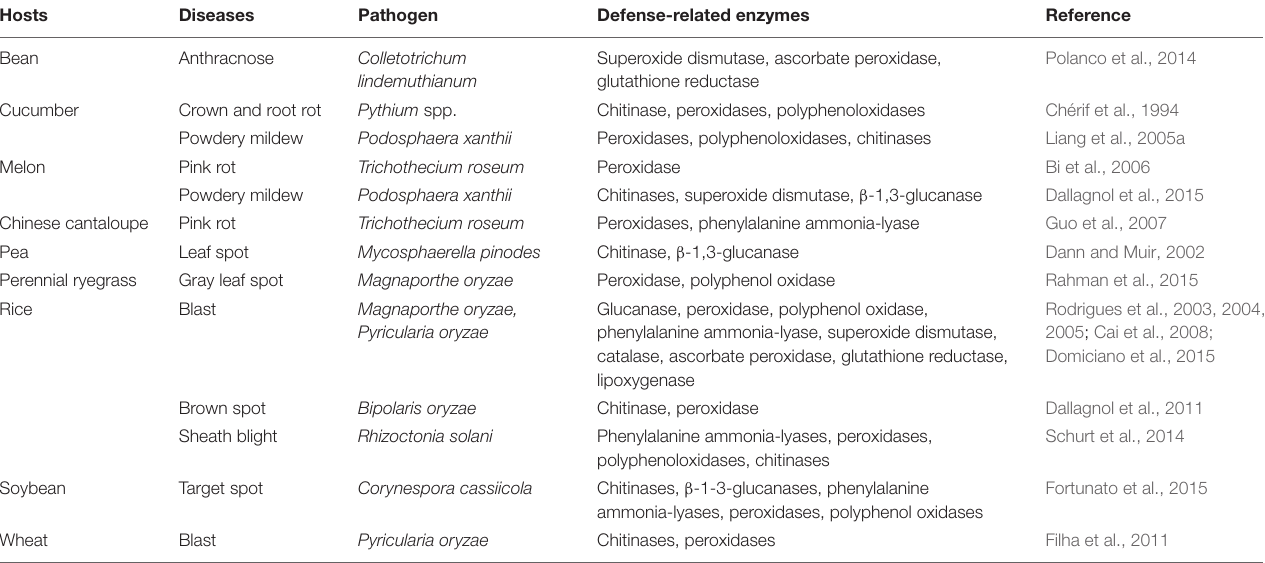
TABLE 2 | Defense-related enzymes regulated by silicon in plant–pathogen